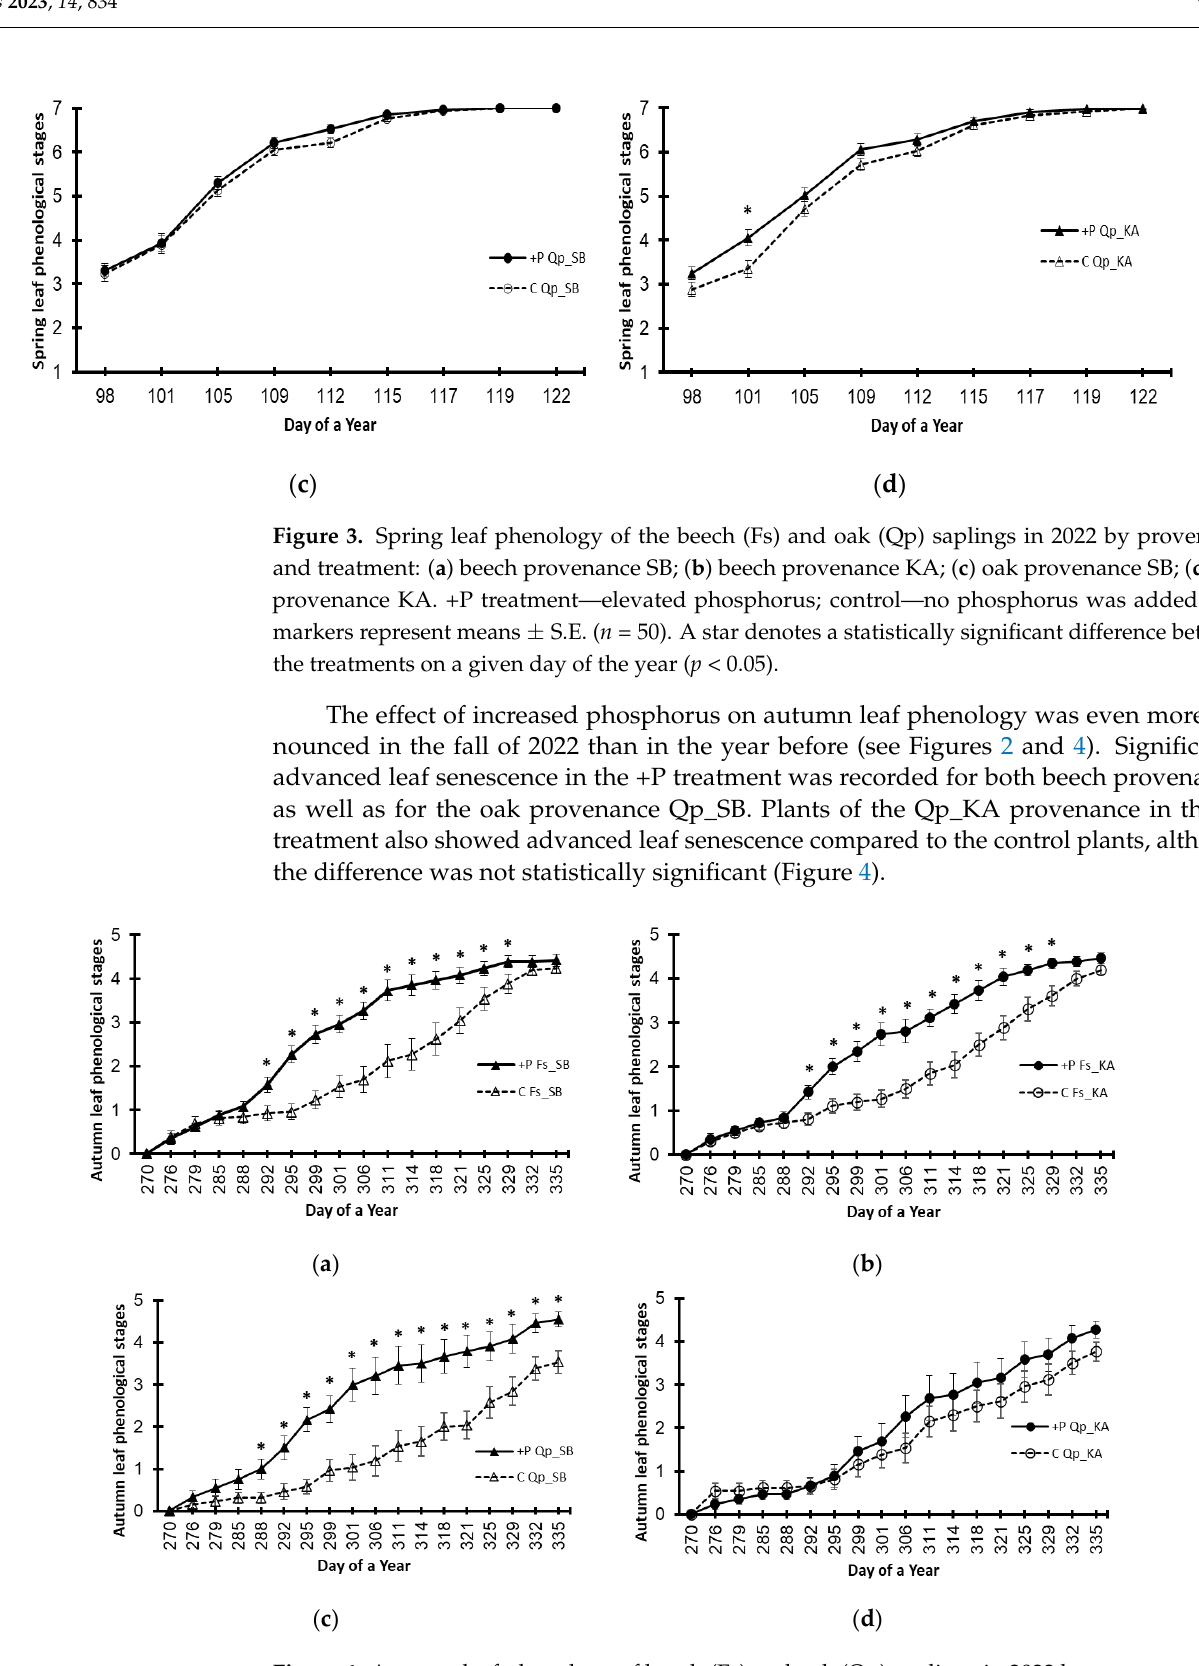
Figure 4. Autumn leaf phenology of beech (Fs) and oak (Qp) saplings in 2022 by provenance and treatment: ( a ) beech provenance SB; ( b ) beech provenance KA; ( c ) oak provenance SB; ( d ) oak provenance KA. +P treatment — elevated phosphorus; C — control (no phosphorus added). The markers represent the means ± S.E. ( n = 50). A star denotes a statistically significant difference between the treatments on a given day of the year ( p < 0.05).